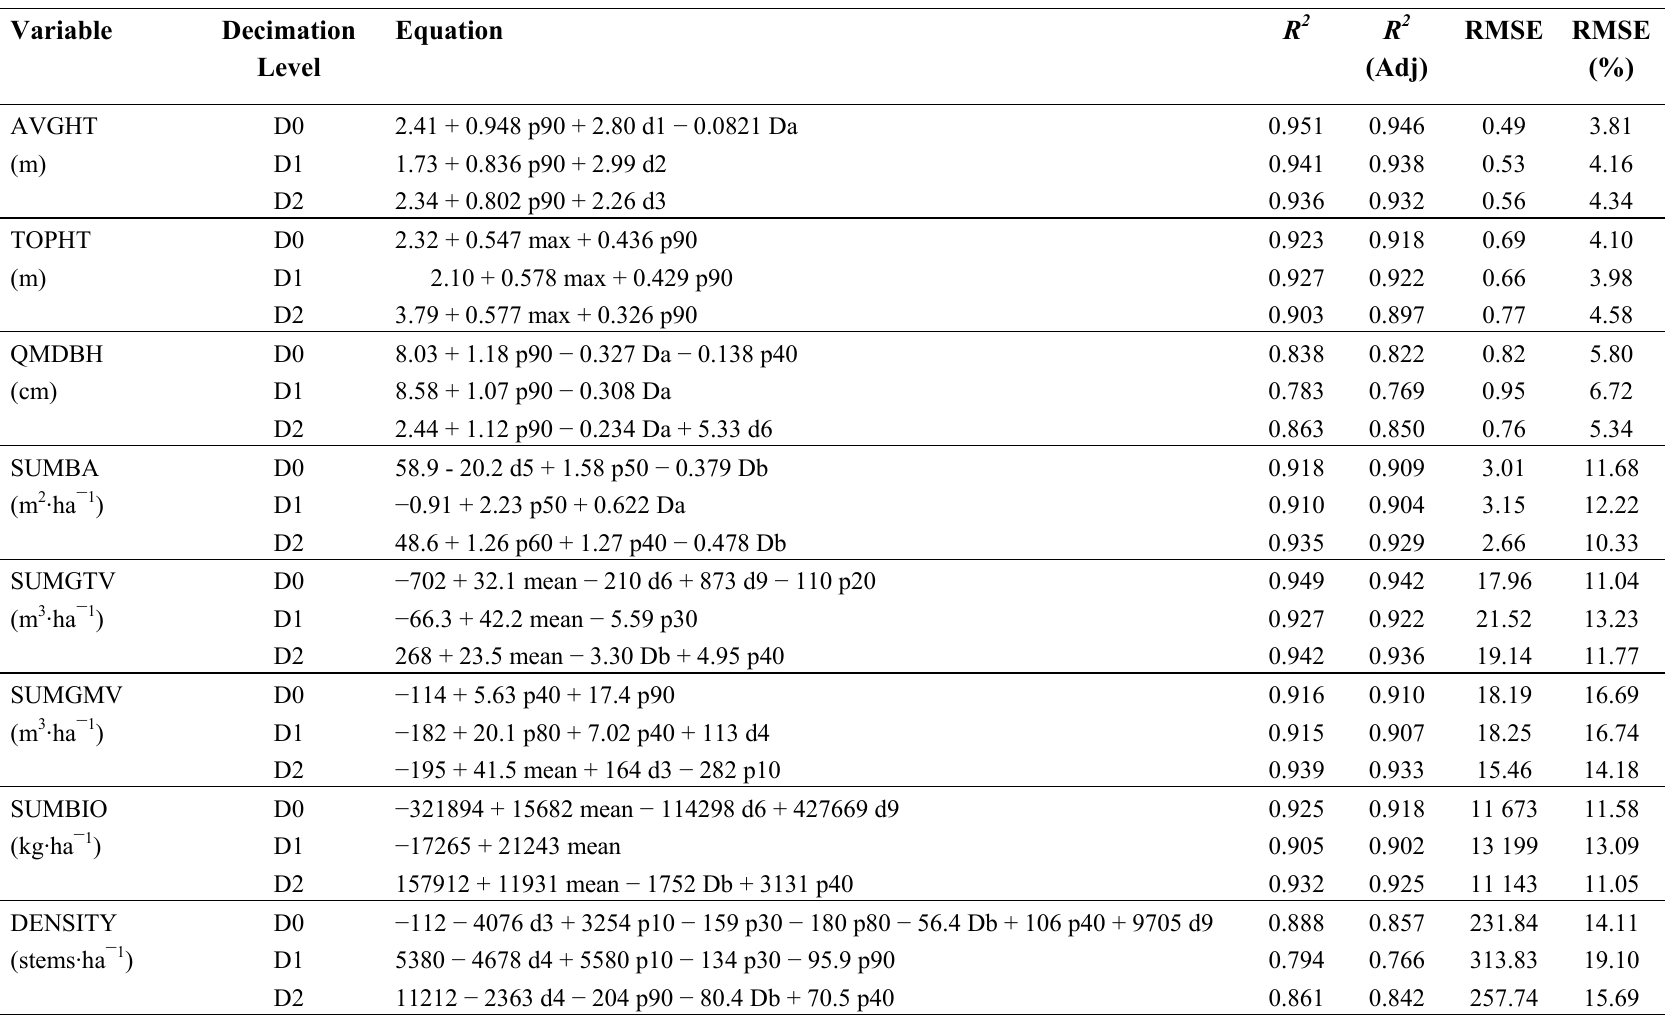
Table 3. Models (and associated statistical descriptors) developed for variables, based on black spruce plots in the RMF. Models are presented for each of the decimation levels ( i.e. , D0 ~ 3.2 pulses m − 2 ; D1 ~ 1.6 pulses m − 2 ; D2 ~ 0.5 pulses m − 2 ). Similar sets of models were developed for SLRF (Tol-Hwd), PRF (GrtLks-Pine), and RMF (Boreal-PJ, Boreal-SB, Boreal-IH and